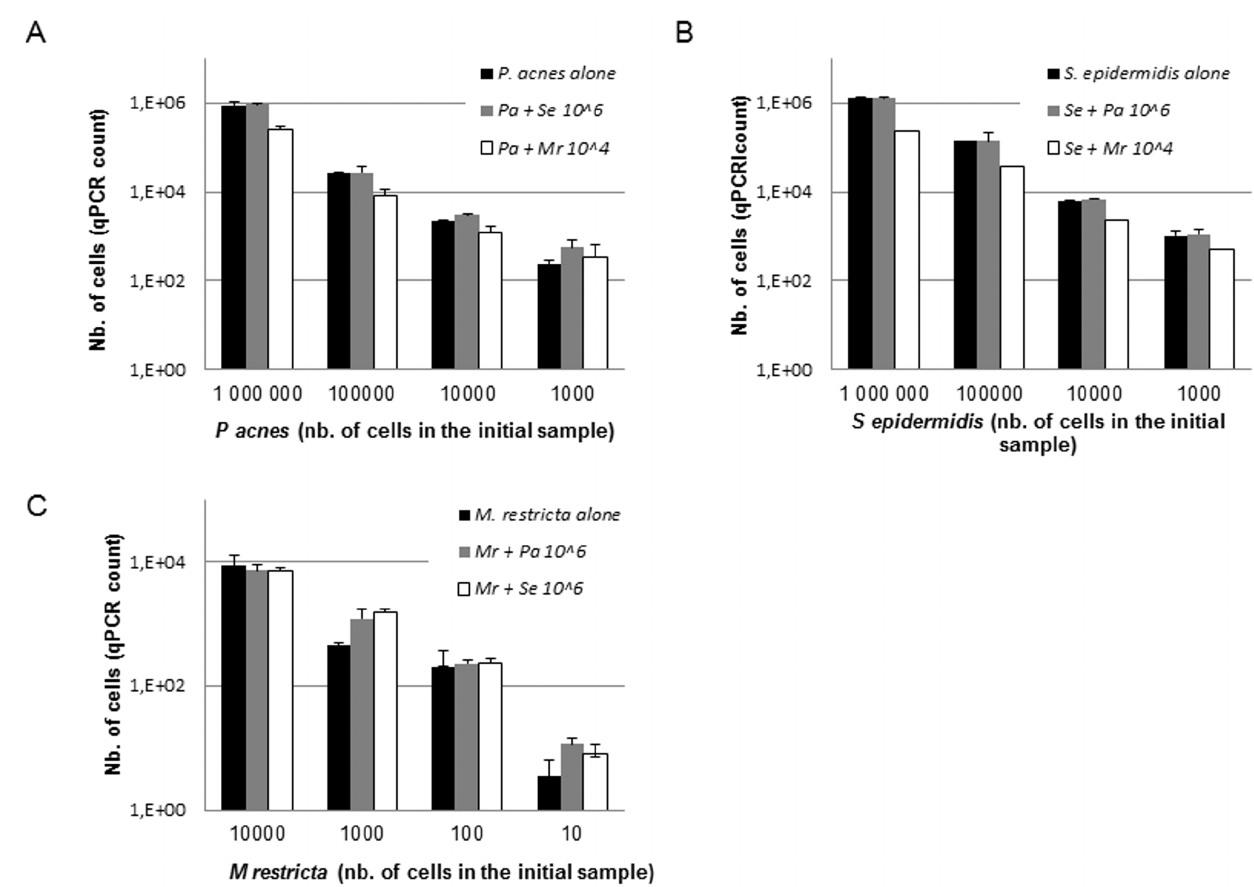
Figure 2. Q-PCR quantification of artificial mixtures containing genomic DNA extracted from S.epidermidis and P.acnes or M. restricta in various ratios. (A) quantification of P. acnes alone or in combination with S. epidermidis (ratios 1:1; 1:10; 1:100 and 1:1000) or M. restricta (ratios 1:0.01; 1:0.1; 1:1 and 1:10); (B) quantification of S. epidermidis alone or in combination with P. acnes or M. restricta in the same ratios and (C) quantification of M. restricta alone or in combination with P. acnes or S. epidermidis (ratios 1:100; 1:1000; 1:10000 and 1:100000). Q-PCR quantification showed the same cell count when the three microorganisms were analyzed alone or in a mixture with the other major skin contaminants.